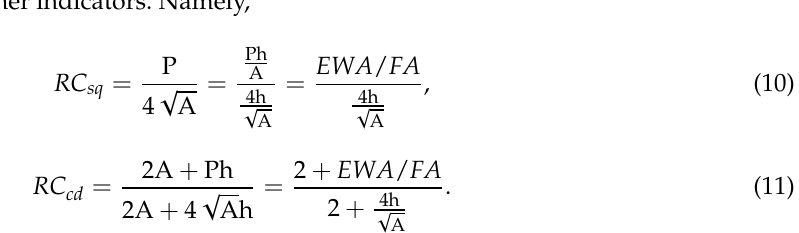
Figure 1: (a) → RC sq = 2.35; LBI = 20, (b) → RC sq = 1.97; LBI = 13.48, and (c) → RC sq = 2.56; LBI = 24.22. The dimensions of the equivalent rectangles (in units of u ) are respectively equal to: (a) 20 × 1, (b) 30.72 × 2.27, and (c) 39.37 × 1.63. Thus, the values of the RC sq and LBI indicators are very large. A rectangular polygon with more than four sides must have concave angles and RDA >